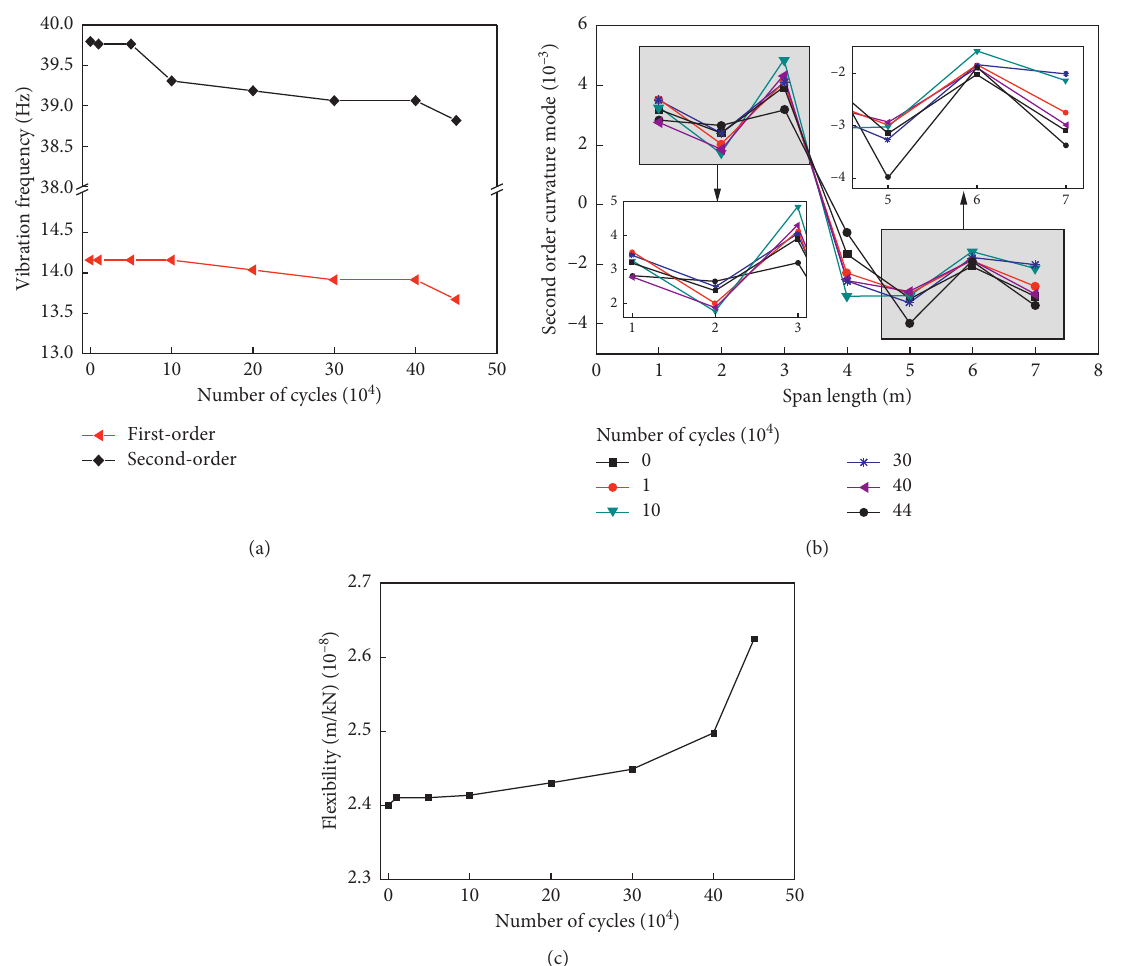
Figure 18: Dynamic performance of JP2 beam: (a) first two order natural frequencies; (b) second-order curvature mode; (c) midspan